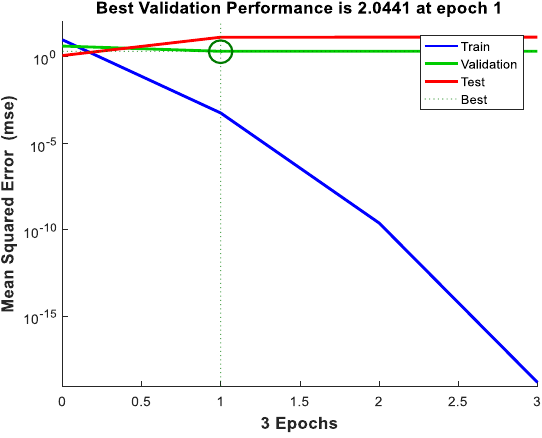
Figure 10. Mean square error (MSE).